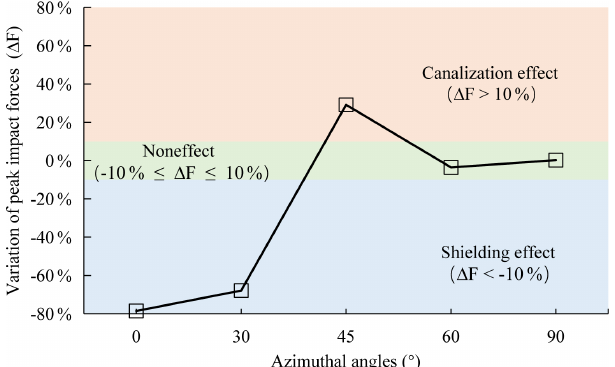
Figure 6. Variations of peak impact forces with increasing azimuth angles in the scenarios of the orientation of 90 ◦ and the opening